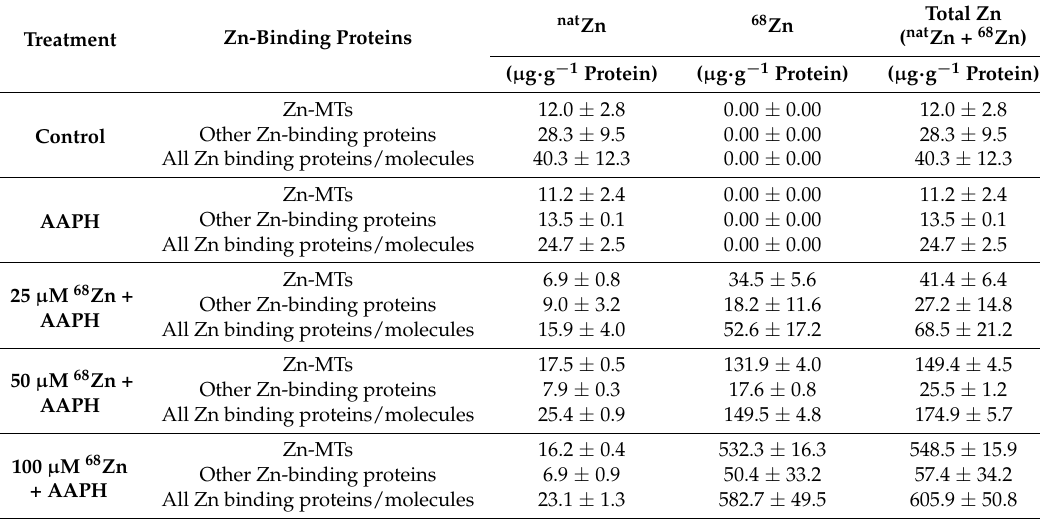
Table 3. Concentration of nat Zn, 68 Zn and total Zn ( nat Zn + 68 Zn) (in µ g Zn · g − 1 protein) found in Zn binding-proteins/molecules, i.e., MTs, other than MTs and all Zn-binding proteins/molecules, in the water-soluble protein fraction of HRPEsv cells by ID-, IPD-SEC-ICP-MS. HRPEsv cells were either